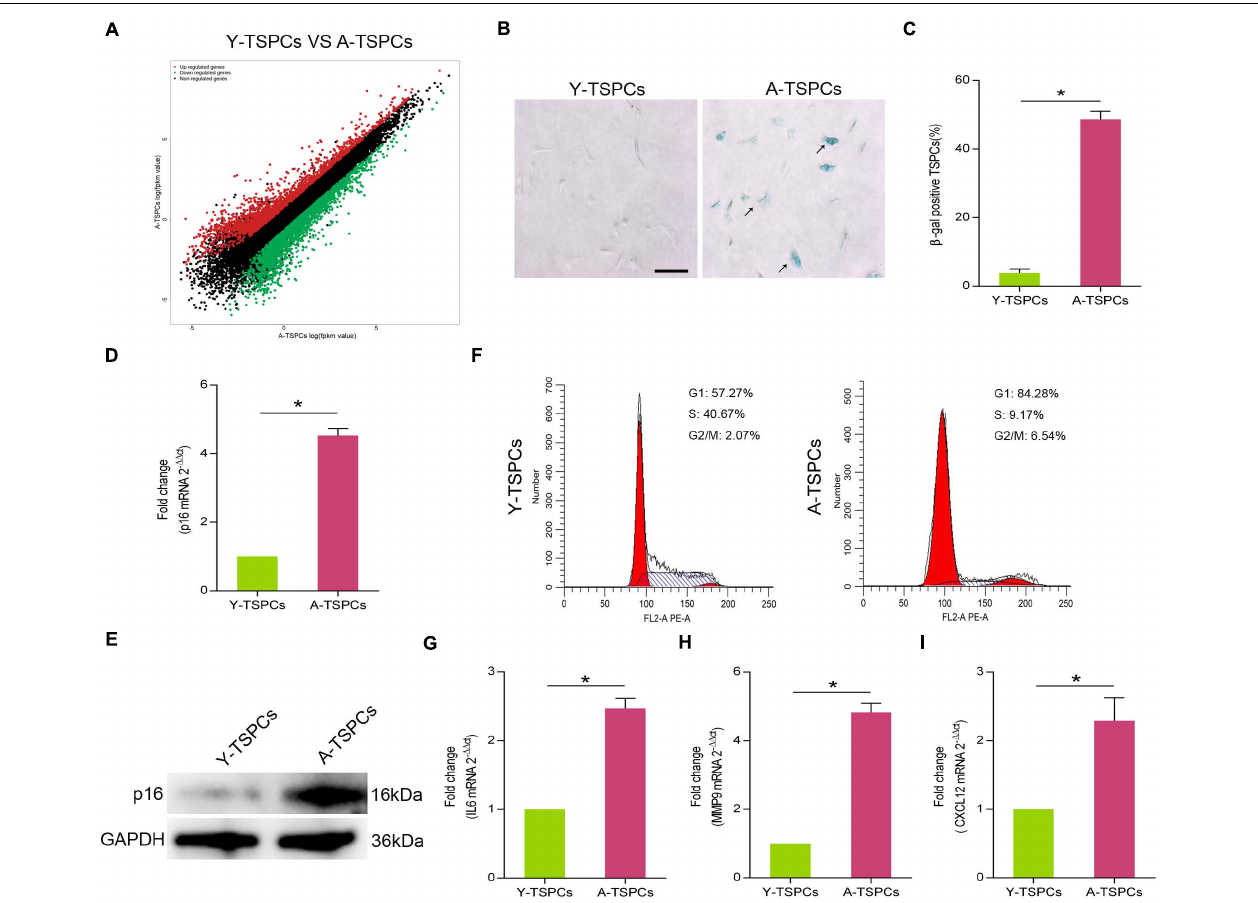
FIGURE 1 | The TSPCs from aged Achilles tendon showed senescence characteristics. (A) RNA-seq analysis of young and aged TSPCs. Scatter plot represents fpkm values for genes expressed in young and aged TSPCs. Red dots show the upregulated and green dots show the downregulated genes (fold change ≥ 2). (B , C) β -gal staining for the senescent cells in young and aged TSPCs. Scale bars: 100 µ m. (D) Relative mRNA levels of p16 INK4A in young and aged TSPCs were investigated by qRT-PCR. (E) Western blotting for the p16 INK4A protein levels in young and aged TSPCs. (F) The cell cycle distribution of TSPCs was measured by flow cytometry. (G – I) qRT-PCR for SASP gene (IL6, MMP9, and CXCL12) expressions in young and aged TSPCs. * P < 0.05 compared with young